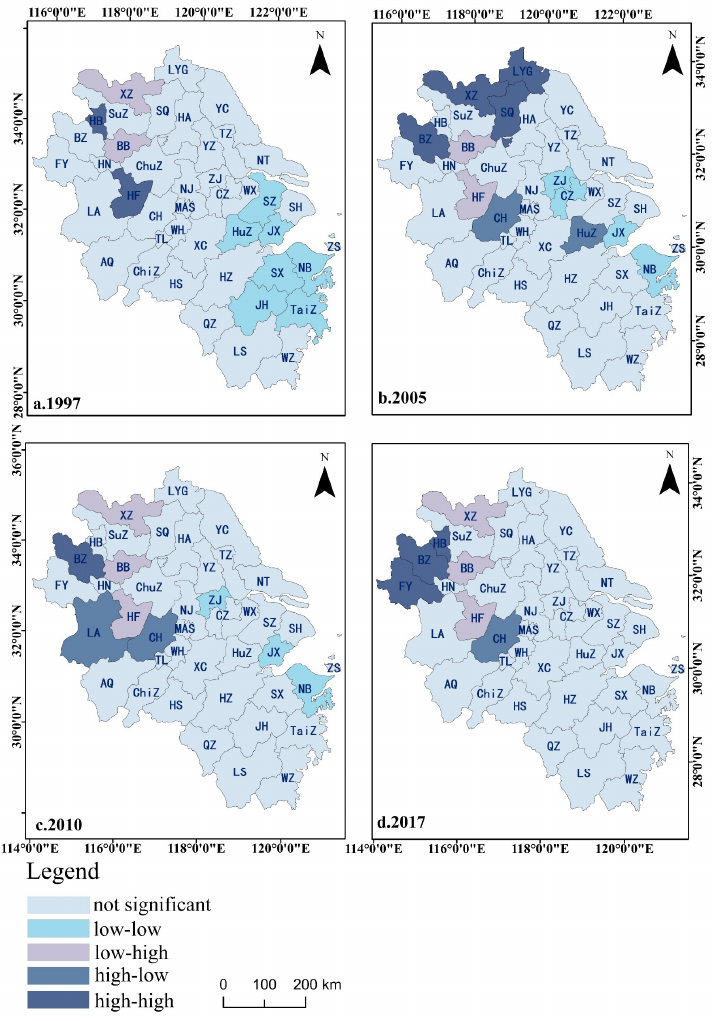
Figure 7. LISA aggregation of carbon emission intensity in the Yangtze River Delta from 1997 to 2017(( a ). LISA aggregation of carbon emission intensity in the Yangtze River Delta in 1997; ( b ). LISA aggregation of carbon emission intensity in the Yangtze River Delta in 2005; ( c ). LISA aggregation of carbon emission intensity in the Yangtze River Delta in 2010; ( d ). LISA aggregation of carbon emission intensity in the Yangtze River Delta in 2017)